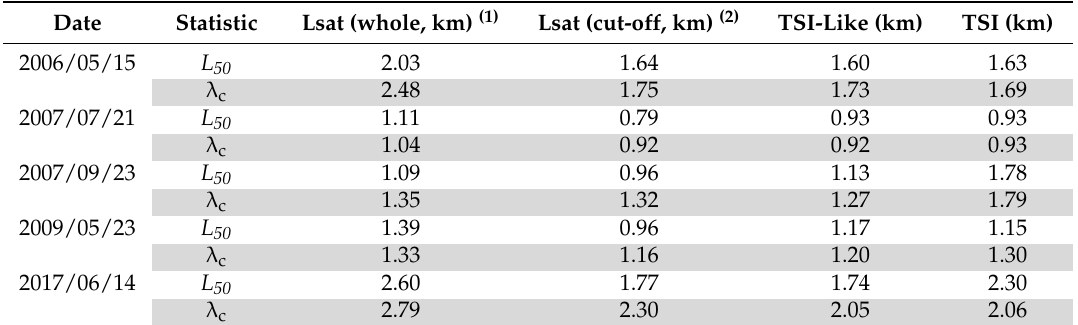
Table 2. Comparison of median of the cloud cover density L 50 and characteristic size λ c for the cloud cover density, σ ( λ ), in Figure